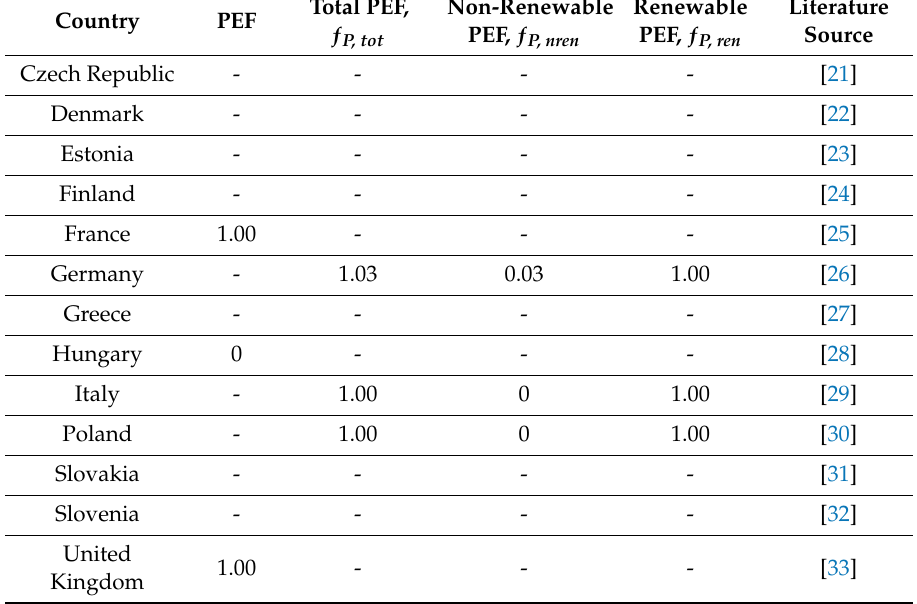
Table 2. The primary energy factor (PEF) values of wind energy used in construction work standards of EU countries. Literature Renewable Non-Renewable Total PEF, Country PEF ƒ P, tot Source PEF, ƒ P, ren PEF, ƒ P, nren - - - - -